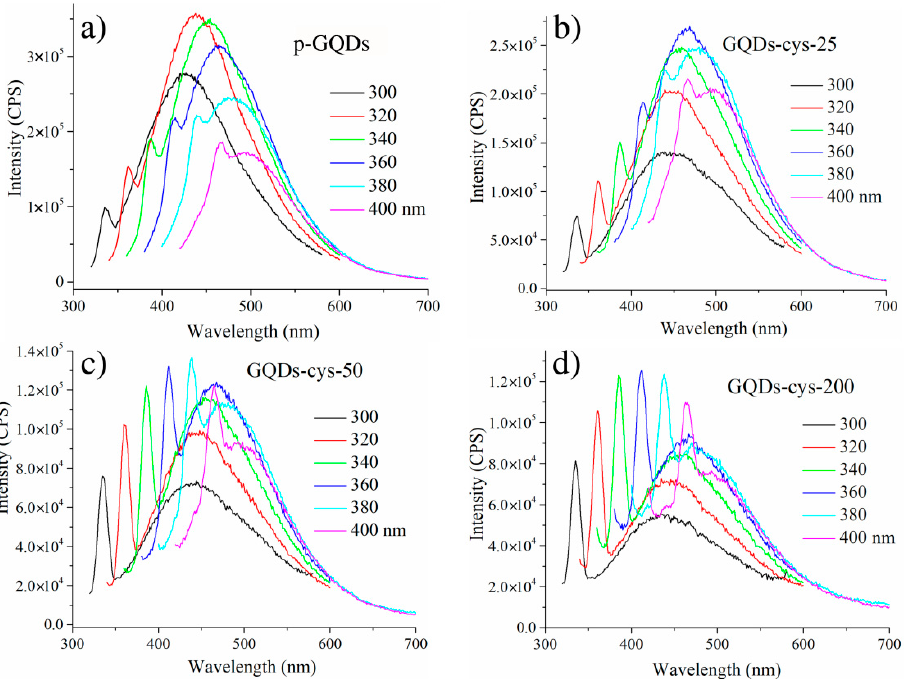
Figure 2. Emission spectra of p-GQDs ( a ), GQDs-cys-25 ( b ), GQDs-cys-50 ( c ) and GQDs-cys-200 ( d ). The excitation wavelengths were between 300 and 400 nm.